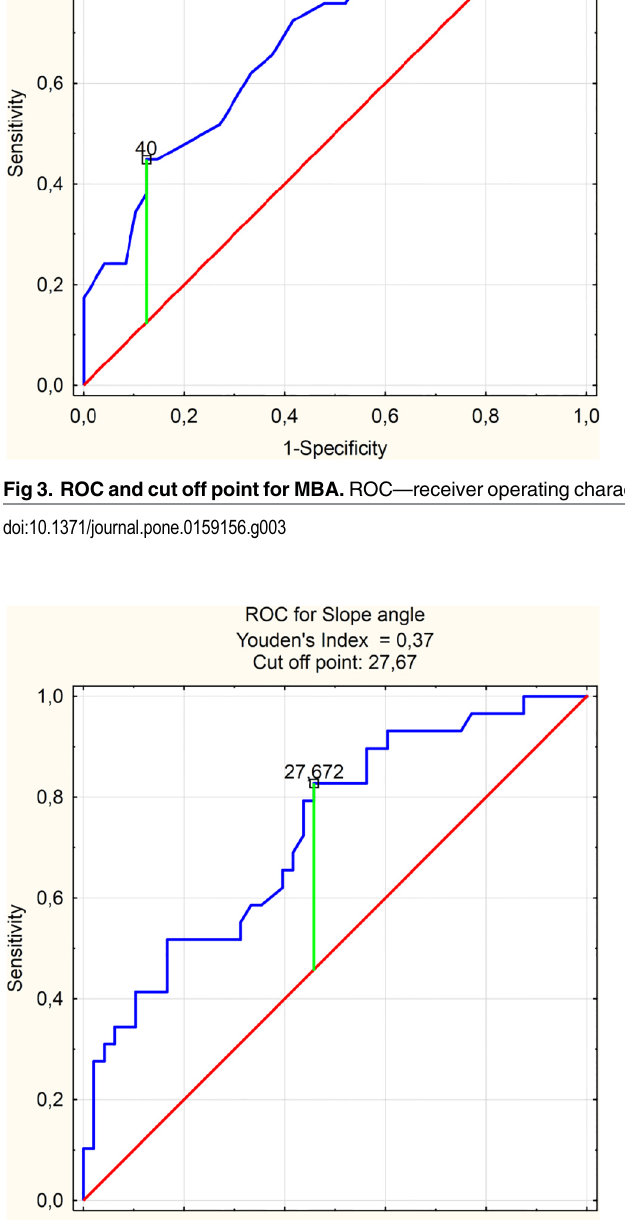
PLOS ONE | DOI:10.1371/journal.pone.0159156 July 14,